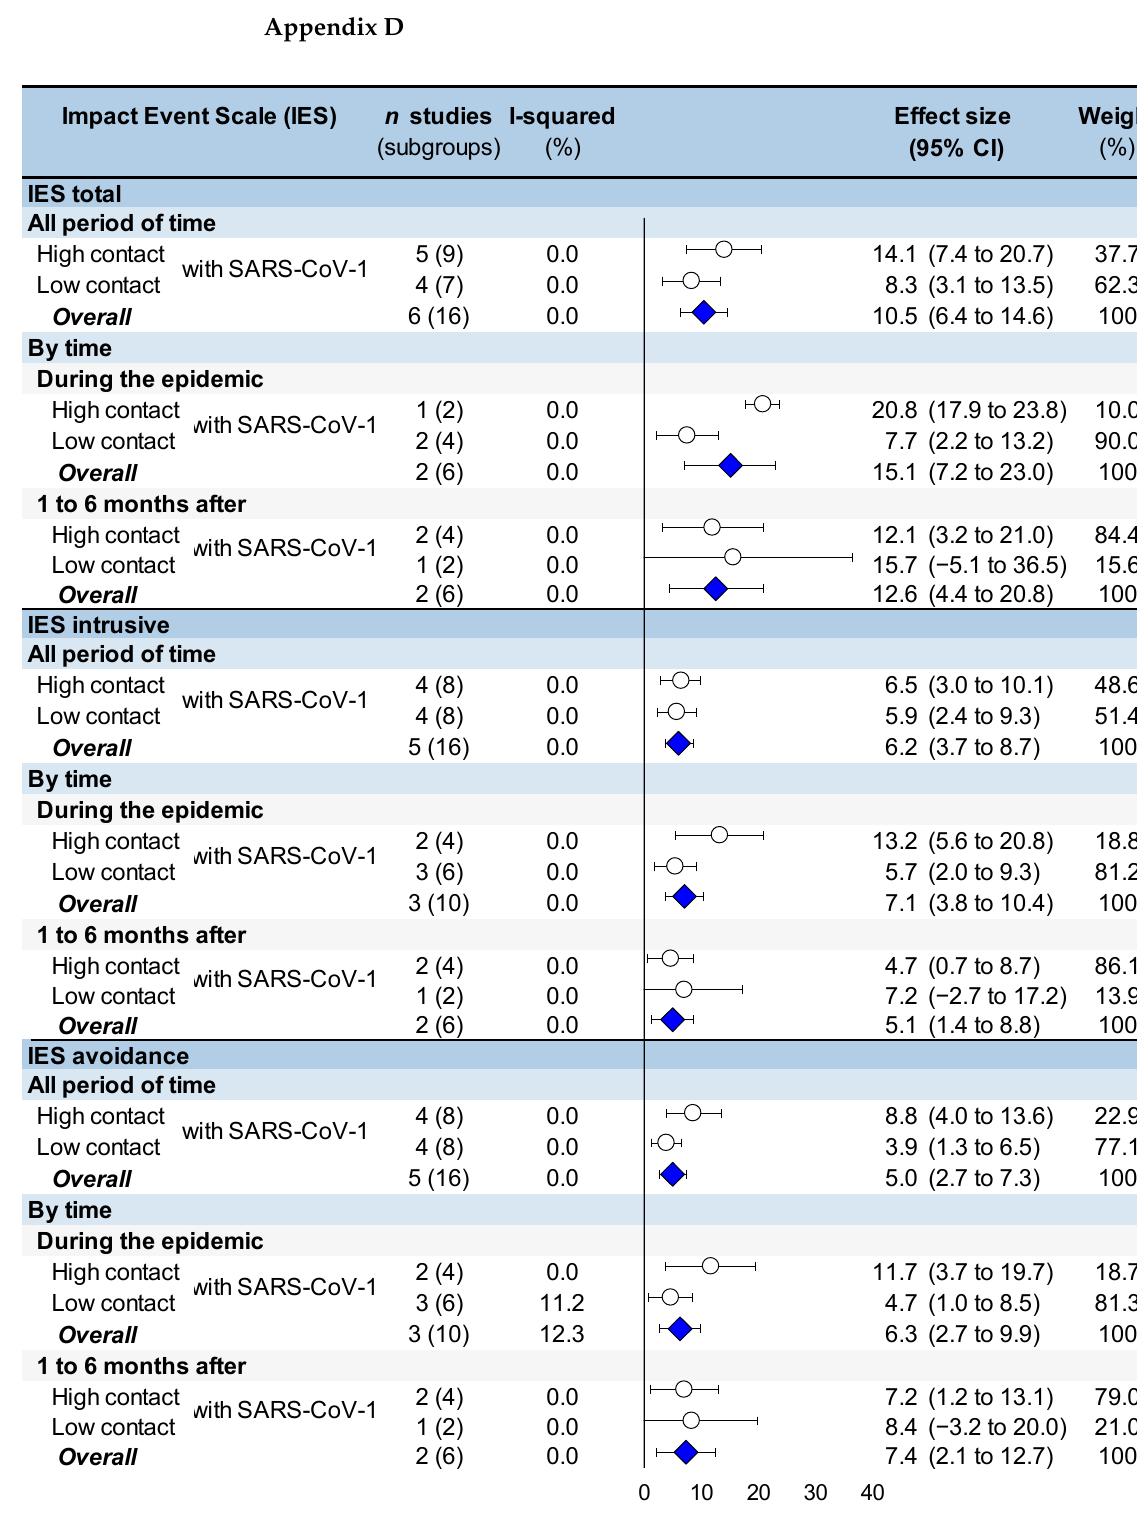
Figure A4. Summary of meta-analysis on IES score (total, intrusive and avoidance) following the SARS-CoV-1 epidemic of 2003, by contact with SARS-CoV-1 (high or low contact) and by time (follow-up). Each summary of meta-analysis is represented in the forest-plot by a white circle (dot) on a horizontal line. An overall summary of the results of meta-analyses is represented by a blue lozenge below.